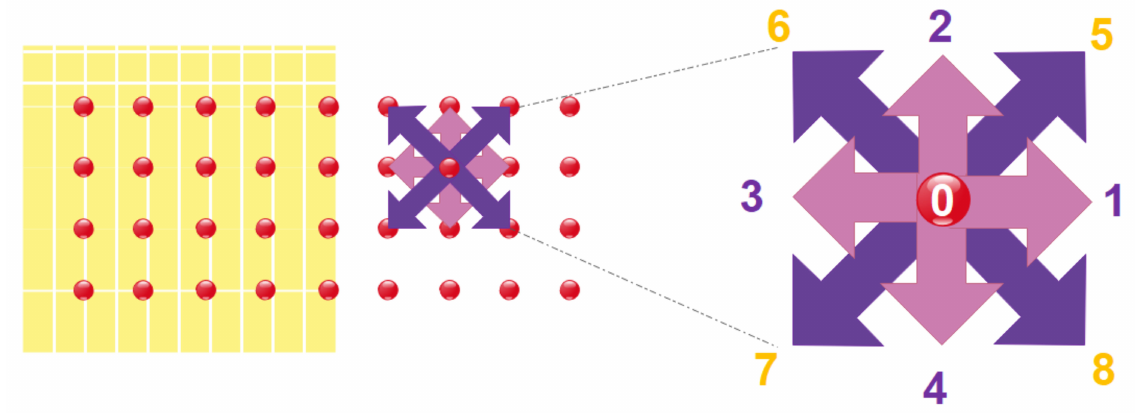
Figure 12. A D2Q9 model arrangement investigated by Shirani and Jafari